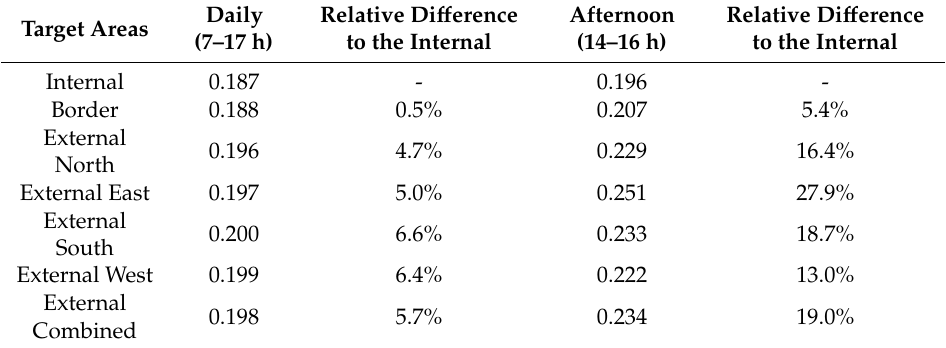
Table 3. Comparison of C ef f averages for daily (7–17 h LT) and afternoon (14–16 h LT) timeframes for all target areas of the Serra da Mesa Reservoir.